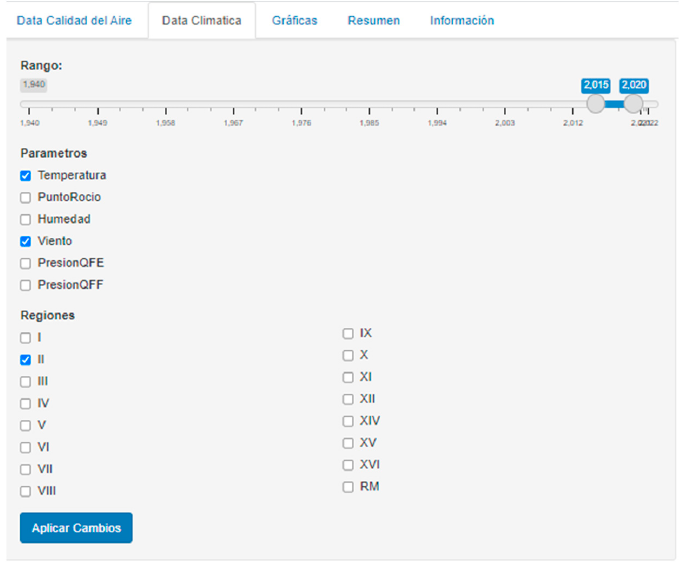
Figure A7. User interface demonstration for request the parameters “Ts” (dry air temperature) “dd” (wind direction) and “ff” (wind speed) data of the stations of Cerro Moreno Antofagasta Ap. And El Loa Calama Ad. between the years 2015 and 2020. Figure A8 shows a time series plot generated with the option “smoothTrend” for Temperature (“Ts_Valor”), showing the monthly averages and the linear trend of the tem- peratures in that period of time.